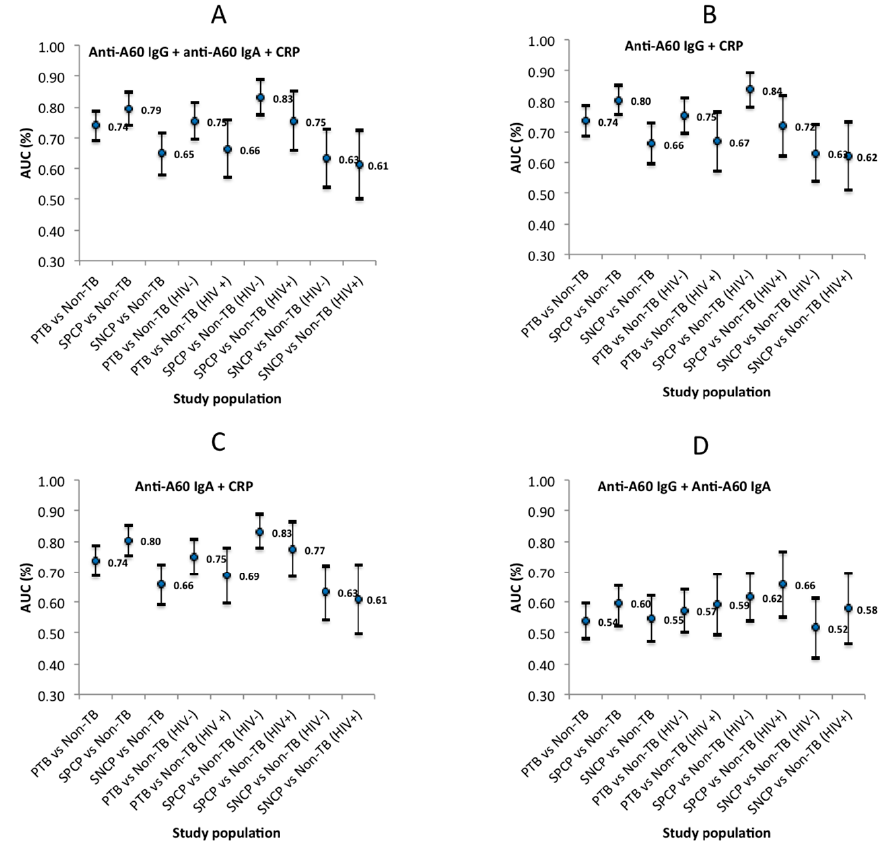
Figure 3. Estimated area under receiver operating characteristics (AUC) (with 95% CI) of four biomarker combinations; ( A ) anti-A60 IgG + anti-A60 IgA + CRP, ( B ) anti-A60 IgG + CRP ( C ) anti-A60 IgA + CRP, and ( D ) anti-A60 IgG + anti-A60 IgA for different study subpopulations.